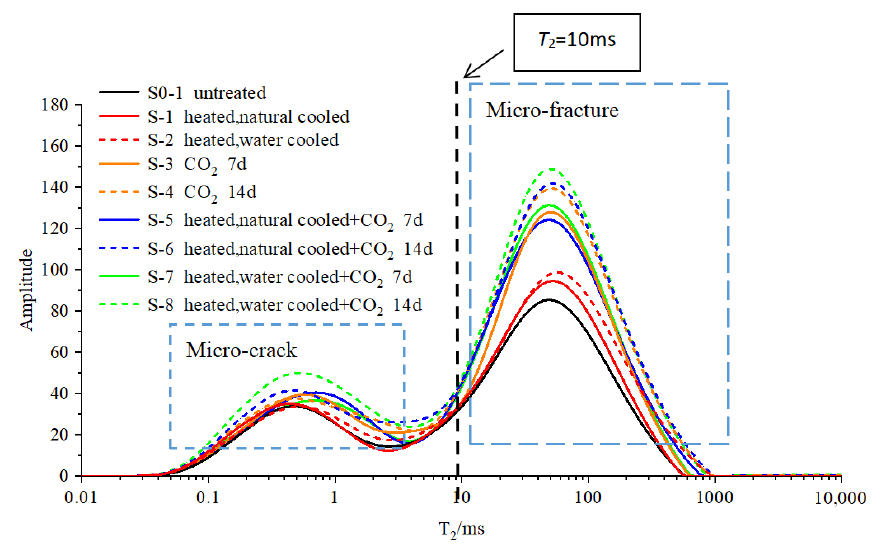
Figure 4. T 2 spectra of granite under the action of different stimulation.